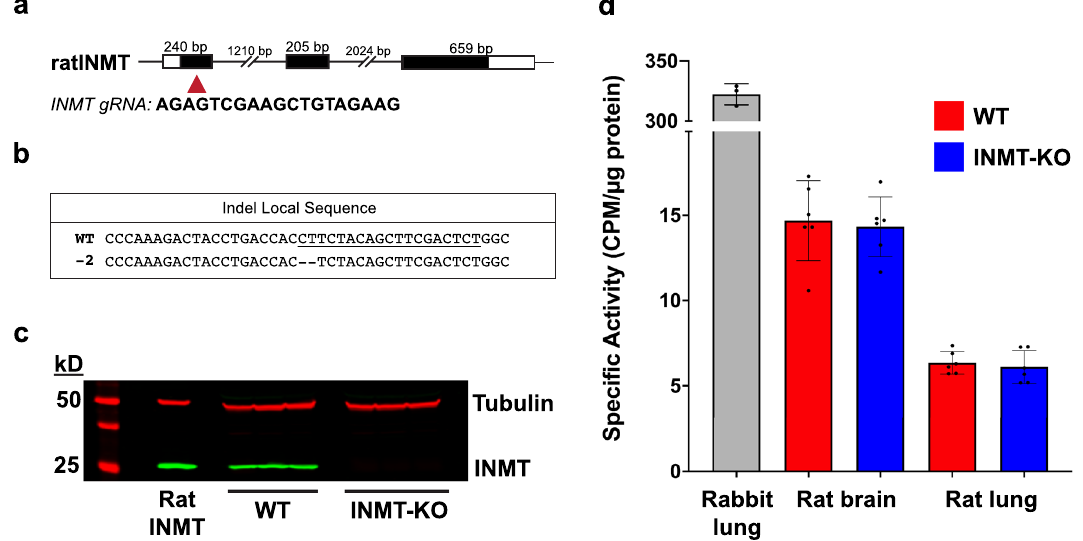
Figure 2. Enzymatic methylation of tryptamine does not differ between WT and INMT-KO rats ( a ) The gene structure of rat INMT with exons represented in black boxes. The location and sequence of the INMT guide RNA (gRNA) is shown with a red triangle. ( b ) The 2-base pair deletion responsible for generating the KO is shown below the wild type (WT) sequence with the location of the gRNA underlined. ( c ) Western blot showing the presence of INMT (green bands) in WT, but not KO rat lung tissues. The original image including all lanes in the molecular weight marker is included as Supplementary Figure S1. ( d ) Radiometric enzyme assays with tissue extracts from rabbit lung, as well as rat brain and rat lung from both WT and INMT-KO rats. Each point represents the average of 3 triplicate experiments from an individual animal for rabbits (n = 3), and rats (n = 6) for each genotype. Plots show averages with error bars indicating standard deviations. CPM: counts per minute. Rabbit lung tissue extracts (n = 3) showed tryptamine-dependent activity > 20-fold higher than rat tissues (average specific activity [SA] = 322.2 ± 8.81, 95% confidence interval [CI] of mean = 300.3–344.0). Tryptamine- dependent activity did not differ between WT and KO rats in brain (t = 0.30, mean difference = − 0.36, 95% CI = − 3.05–2.33, p = 0.77) or lung tissues (t = 0.52, mean difference = − 0.25, 95% CI = − 1.33–0.84, p = 0.62). In brain, average SA was 14.68 ± 2.34, 95% CI of mean = 12.22–17.13 in WT, and 14.32 ± 1.76, 95% CI of mean = 12.47–16.16 in KO. In lung, average SA was 6.36 ± 0.66, 95% CI of mean = 5.66–7.05 in WT, and 6.11 ± 0.96, 95% CI of mean = 5.10–7.12 in KO. Tryptamine-dependent activity was significantly higher in brain tissues relative to lung ( t = 8.38, mean difference = 8.32, 95% CI = 5.87–10.77, p = 0.0002 for WT and t = 10.04, mean difference = 8.21, 95% CI = 6.31–10.11, p < 0.0001 for